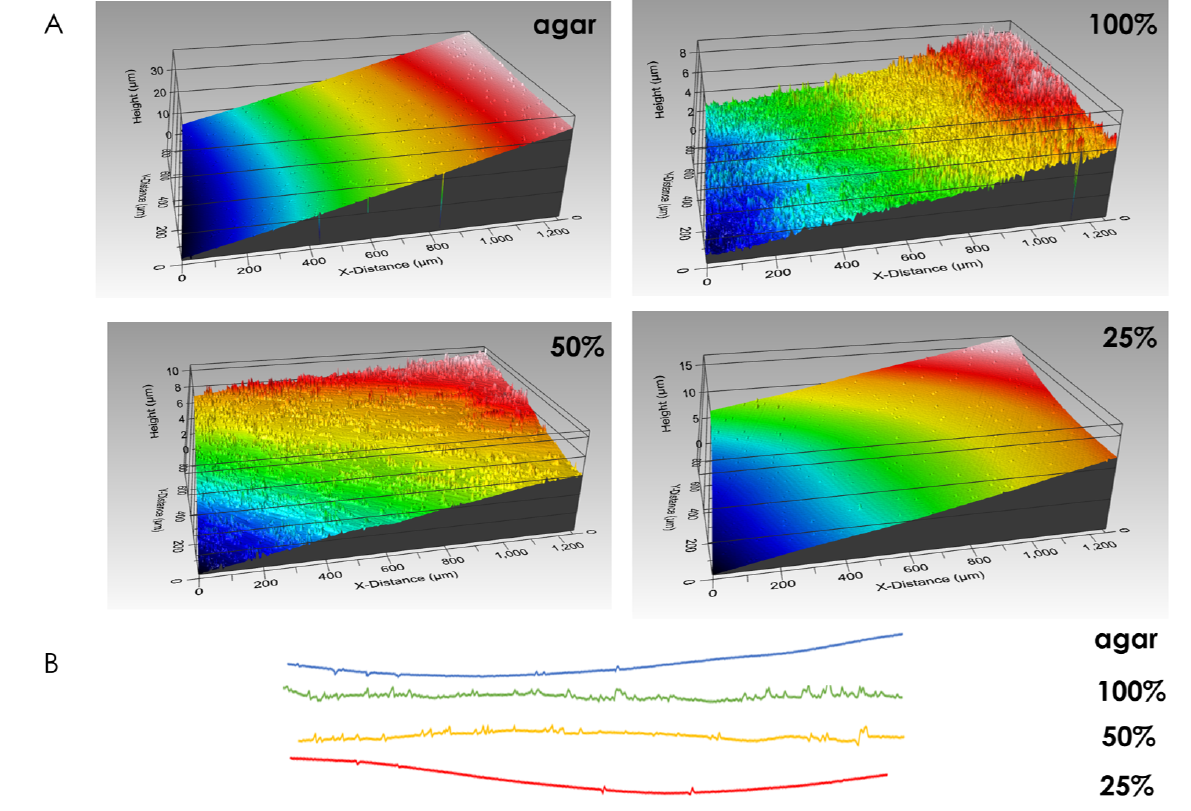
Figure 5. Biofilm footprint upon solid agar medium. ( A ) Surface rendering of growth media after removal of macrocolonies. Control surface on which no bacteria were seeded is shown in top-left image. ( B ) Line roughness profiles corresponding to surfaces in ( A ). The results are representative of six